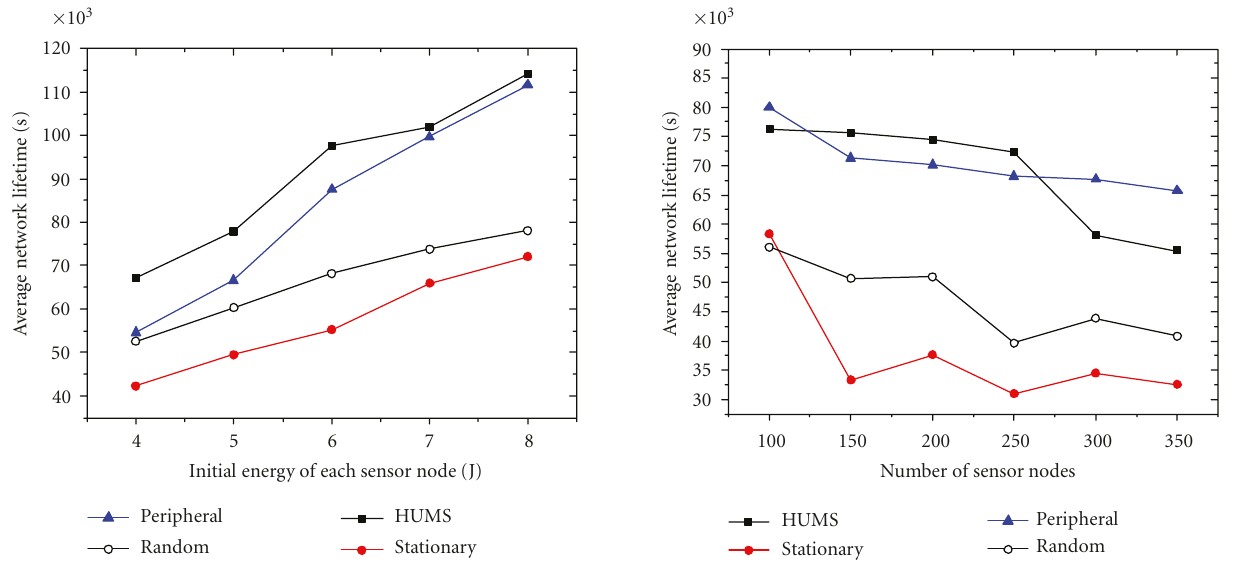
Figure 7: Network lifetimes varied with di ff erent node densities. (The initial energy for each node is 8 J.)